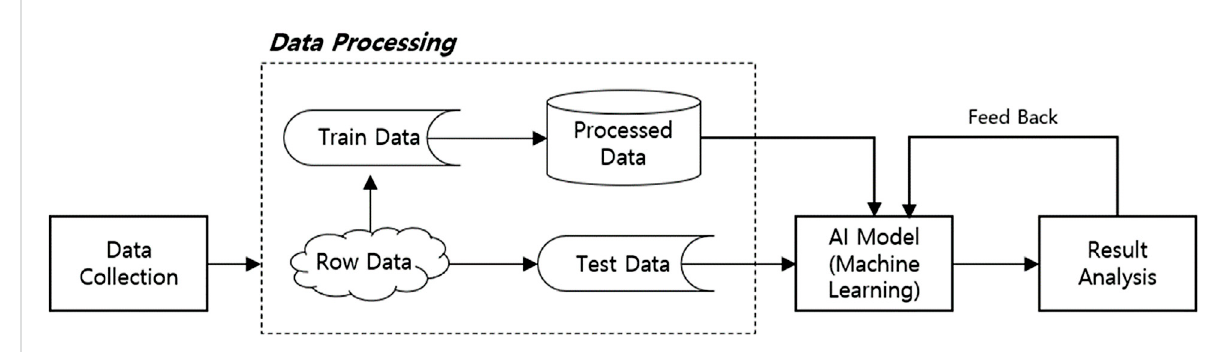
FIGURE 1 Proposed approach employed in the study as a block diagram (Arora and Kaur, 2020).